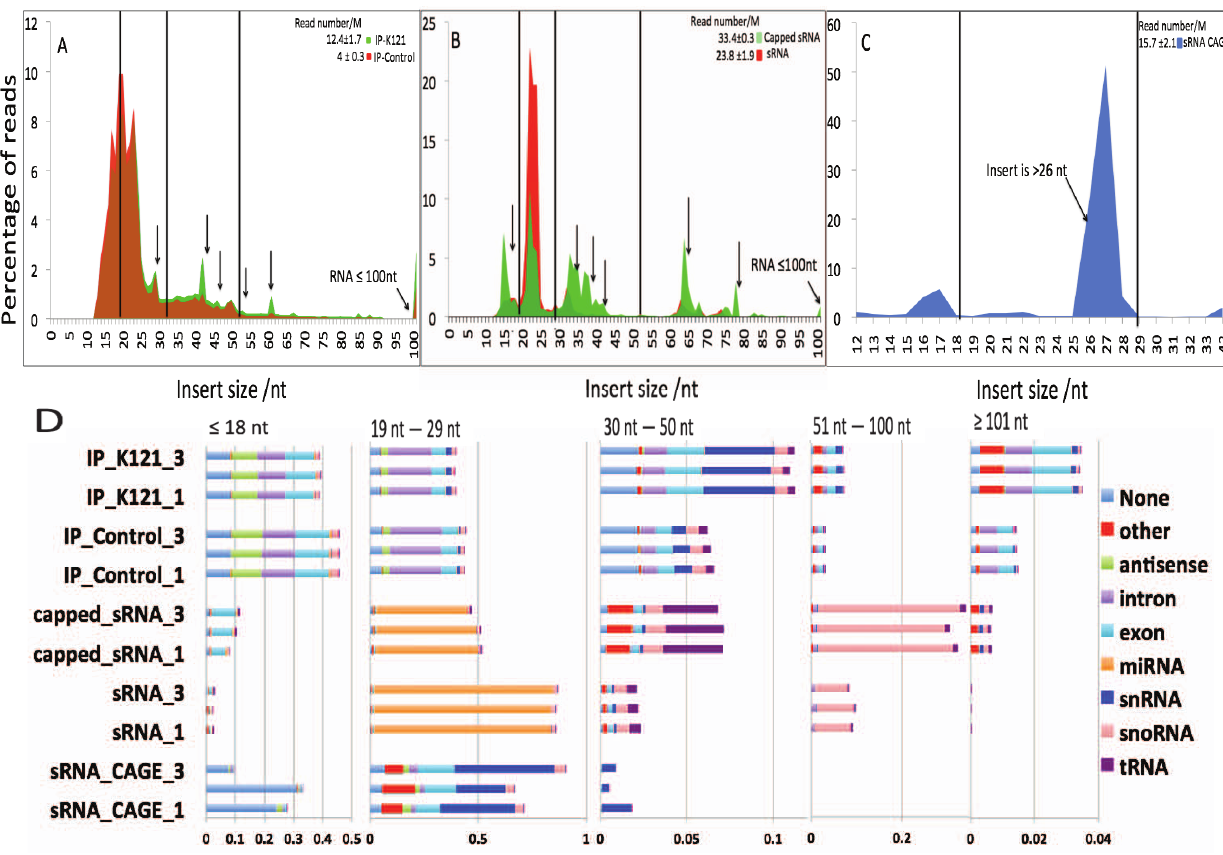
Figure 2. Comparison of libraries identifies enriched sRNA lengths and annotations. A–C: Size profile of the immunoprecipitated (A), TAP- treated (B) and CAP trapped sRNA libraries and their controls. D: Annotations per length range, represented by stacked bar plots for each library replicate. None means that no annotation was found, and other combines all annotations categories that were not listed individually.